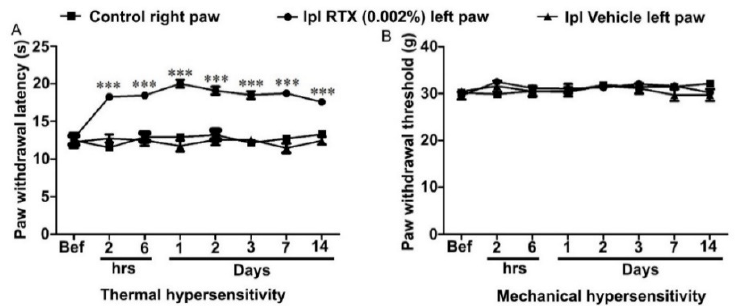
Figure 1. Thermal and mechanical paw withdrawal latency was measured before and after RTX (0.002%, 100 µL) or vehicle injection in the skin of left hind paw of rats. Thermal paw withdrawal latency of RTX-injected left hind paw was significantly (*** p < 0.001) increased at different time points compared to vehicle-injected left hind paw or right control paw ( A ). In contrast, no significant difference was observed in the mechanical paw withdrawal latency of RTX-injected left hind paw compared to vehicle-injected left hind paw or right control paw ( B ) [(*** RTX vs. vehicle/right control) n = 7 each group].